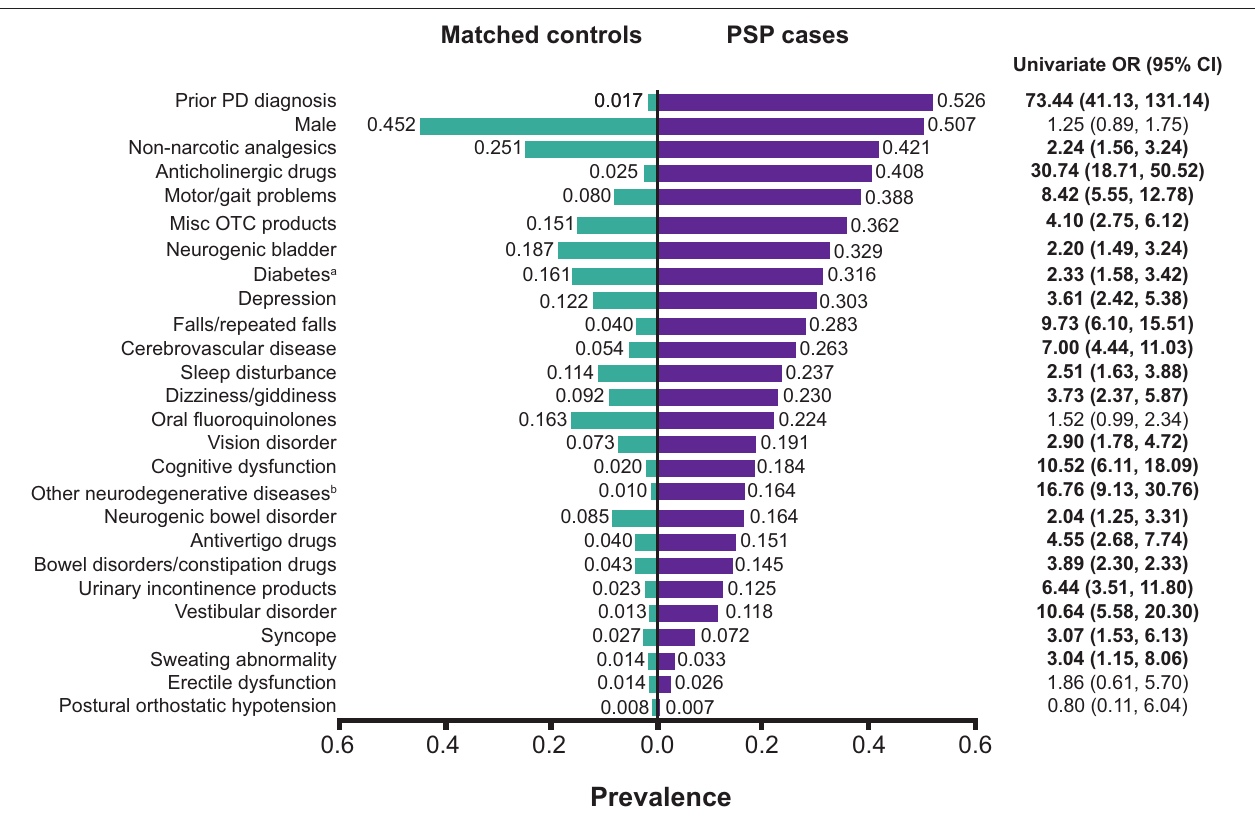
FIGURE 2 | Prevalence of clinical factors during the pre-diagnostic phase by PSP case and control status. a Including both type 1 and type 2 diabetes. Among PSP cases with diabetes, 8.3% had type 1 diabetes only, 87.5% had type 2 diabetes only, and 4.2% had both type 1 and type 2 diabetes. All of the matched controls had type 2 diabetes, including 0.6% who had both type 1 and type 2 diabetes. b Neurodegenerative diseases other than PD or PSP. CI, confidence interval; misc, miscellaneous; OR, odds ratio (values in bold letters indicate statistically significant associations with PSP status); OTC, over-the-counter; PD, Parkinson’s disease; PSP, progressive supranuclear